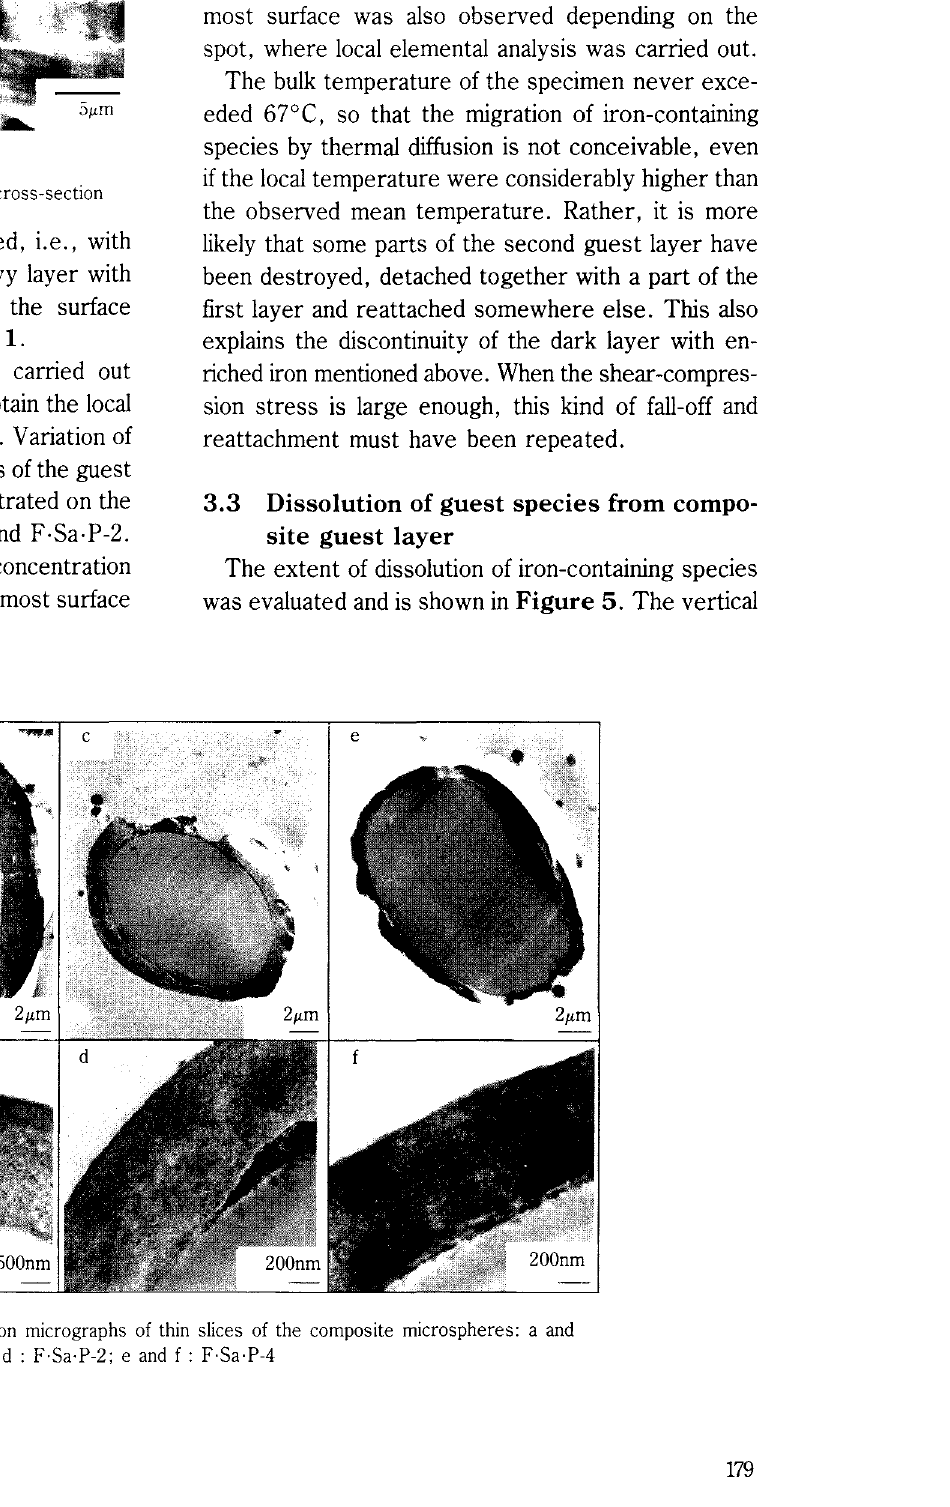
Fig. 3 Transmission electron micrographs of thin slices of the composite microspheres: a and b : F·Sa·P-1; c and d : F·Sa·P-2; e and f: